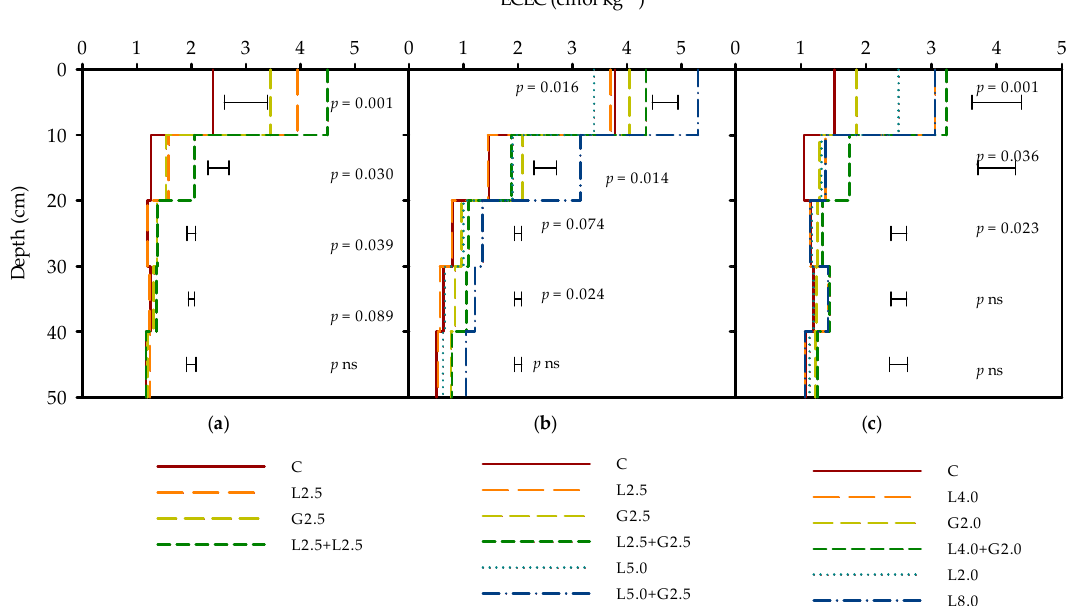
Figure 5. ( a ) Soil ECEC in the ST for C, L2.5, G2.5, L2.5 + G2.5 treatments, ( b ) in the MT for C, L2.5, G2.5, L2.5 + G2.5, L5.0, and L5.0 + G2.5 treatments; and ( c ) in the LT for C, L4, G2, L4 + G2, L2, and L8 treatments. Error bars represent least significant difference values at p = 0.05, n = 3 for each depth with ns denoting p > 0.05.